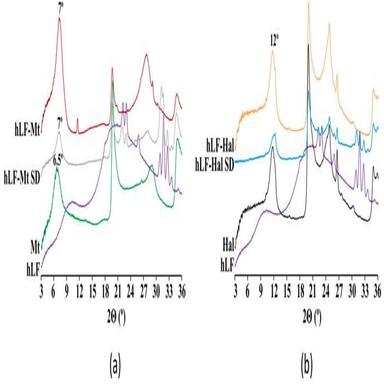
XRPD patterns of nanohybrids and pristine components: (a) Mt-based nanohybrids; (b) Hal-based nanohybrids.